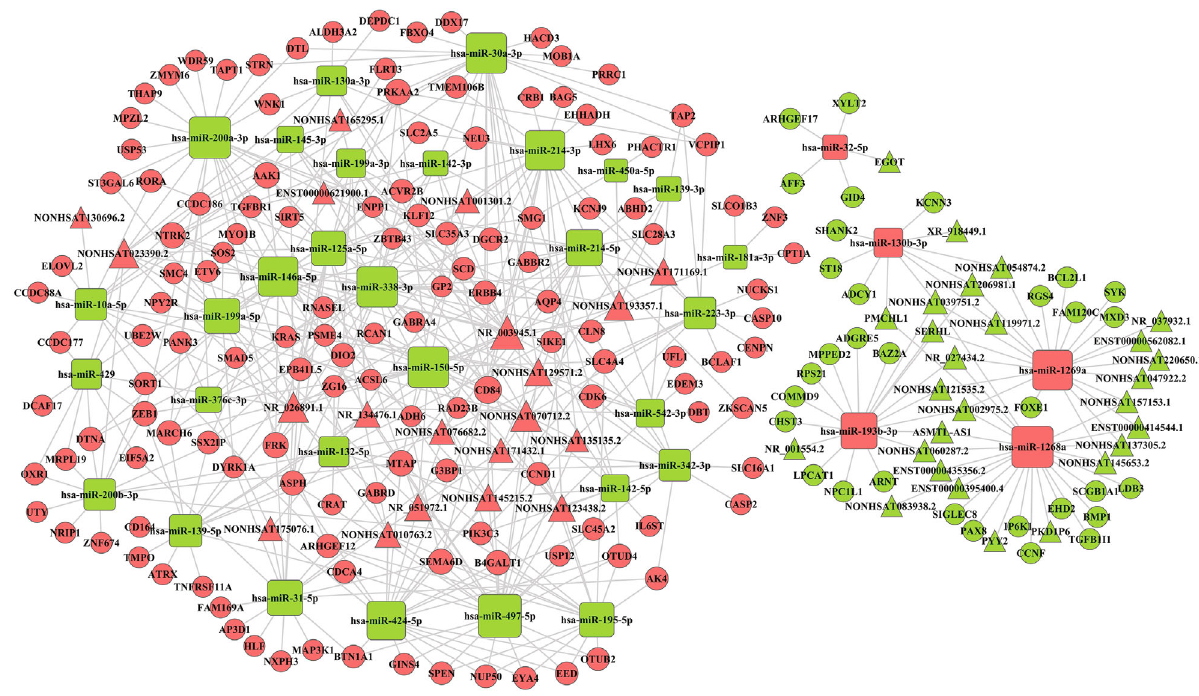
Figure 2: The ceRNA network of lncRNA-miRNA-mRNA. Triangles represent lncRNAs; rectangles with rounded corners represent miRNA; balls represent mRNAs. Red represents upregulated RNAs, and green represents downregulated RNAs. lncRNA: long noncoding RNA; miRNA: microRNA; mRNA: messenger